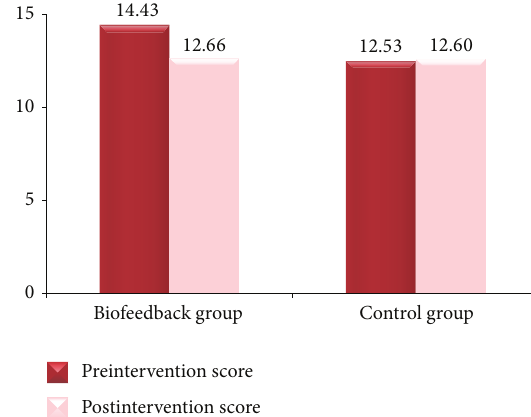
Figure1:Pre-andpostinterventionmeanscoresforPerceivedStress